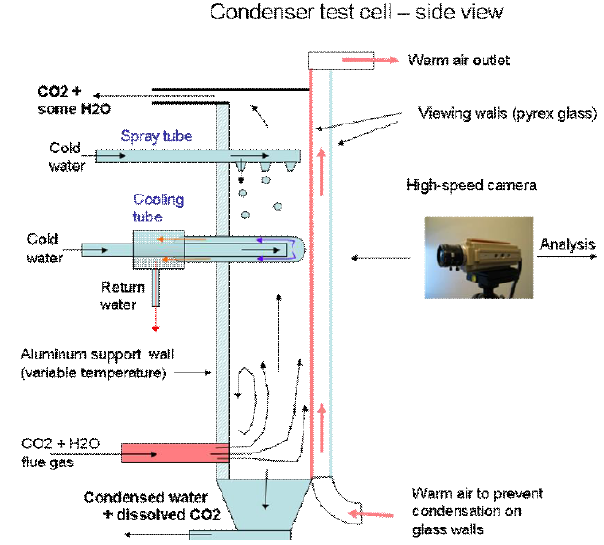
Figure 11. Direct contact condenser—scheme [89]. Table 24. Simulation results and assumptions [89].